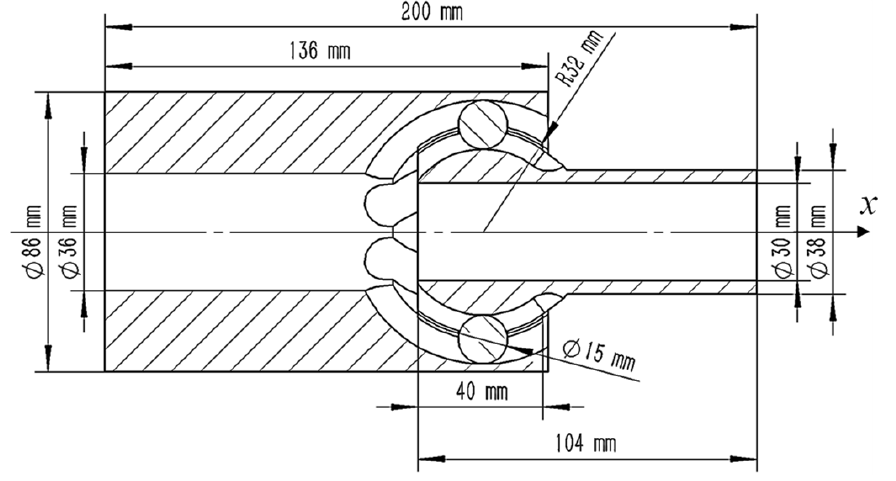
Figure 9. Structural parameters of ball cage flexible joint.